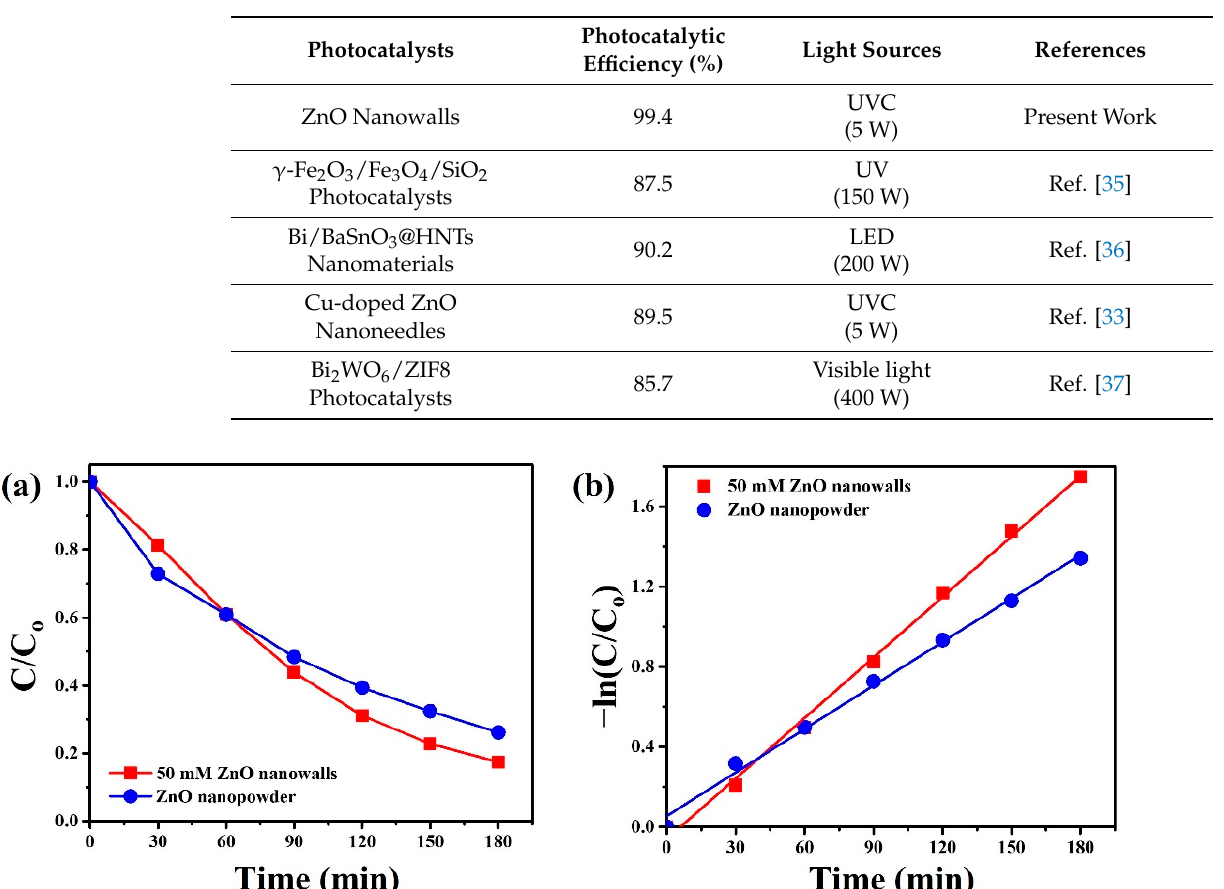
Table 1. The degradation of methylene blue over photocatalysts published compared to our work.